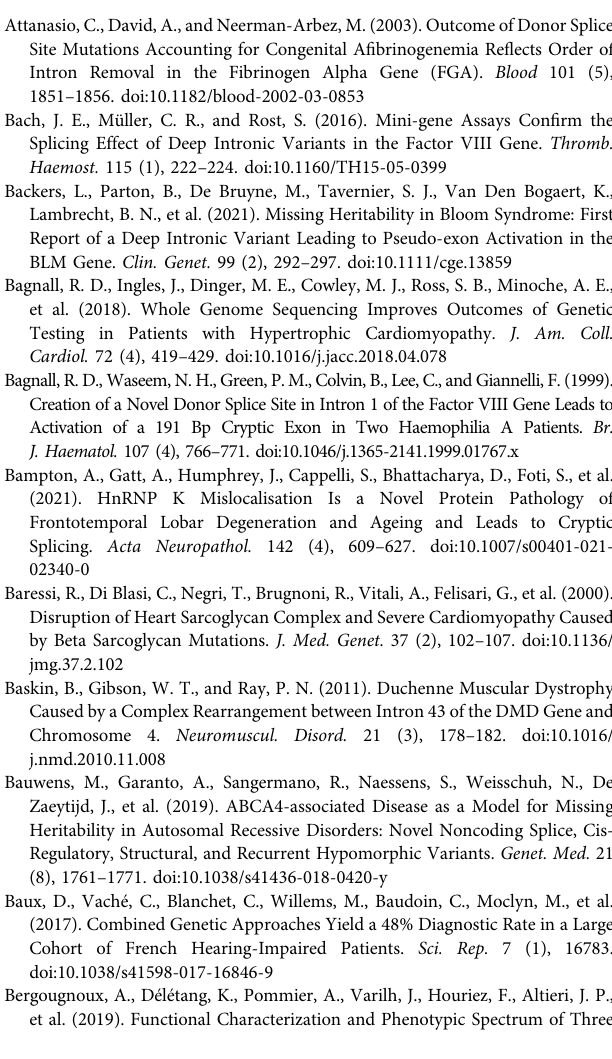
fl anking canonical exons in light grey and intervening introns as solid black lines. Sizes are not to scale. Dash-lines elsewhere indicate altered splicing of canonical exons. Roman numeral “ IV ” indicates an identical sequence inclusion to one shown in Supplementary Figure S1 . Selected relevant features for each mutation are indicated where appropriate, with full details and references provided in Supplementary Table S1 . Numbers above exon ends indicate acceptor and donor Maximum Entropy splice site scores, with “ NF ” indicating a site that is non- functional in the reference (NF - > score) or mutant (score - > NF) allele due to lacking an essential AG-GY dinucleotide. “ +D ” indicates one or more gain-of-donor-motif mutations. Other motif changes are indicated with vertical lines and labelled as “ ± name-of-motif. ” Vertical brackets indicate common features of enclosed splice events. *Variant-induced increase in splicing of FBXO38 -9-1 was low (from 8 to 13% of FBXO38 transcripts) but statistically signi fi cant (Saferali et al., 2019). Supplementary Figure 3 | A G > A substitution within RPGR intron 9 creates a binding motif for KHDRSB1 (Sam68), potentially altering the splicing of an adjacent pseudoexon ( RPGR -9-1) that originates within an AluSx element. Image captured from UCSC Genome Browser , GRCh38/hg38. Location of TTAAA motif indicated with a thick vertical red line, and additional annotations are written in red text. Scale at top shows chromosome X coordinates. “ GENCODE V36 ” track shows aligned transcripts, with gene names on the left, solid bars indicating exons and horizontal lines indicating introns. Arrows ( < and > ) on introns indicate transcript reading direction relative to chromosome + strand. “ Repeating Elements ” track shows alignments of SINE or LINE elements as solid rectangles, with darker shading indicating higher homology to the reference sequence for that